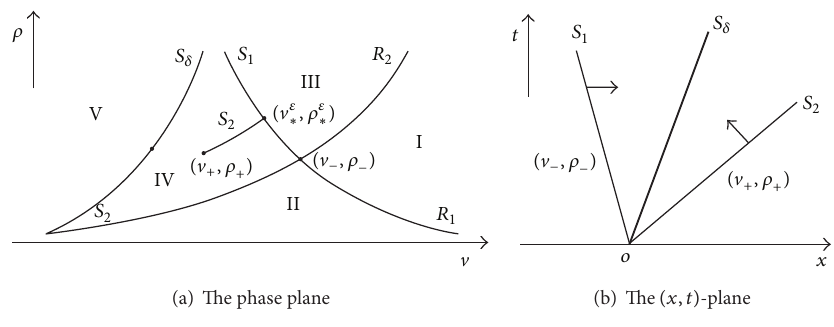
Figure 3: Riemann solutions when ( V + ,𝜌 + ) ∈ IV ( V − , 𝜌 − )